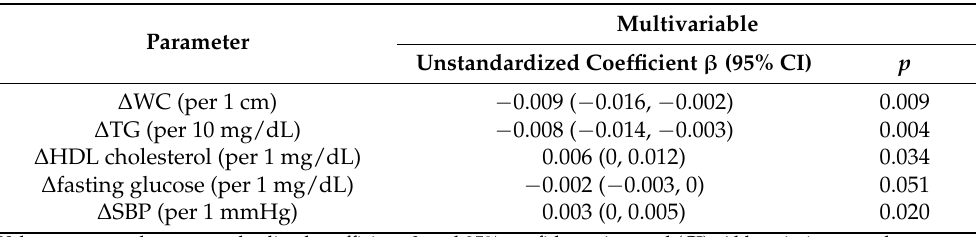
Table 4. Association of (cid:52) MetS components with BMD (cid:52) T-score using multivariable linear regression analysis in participants with MetS (no, yes) ( n =